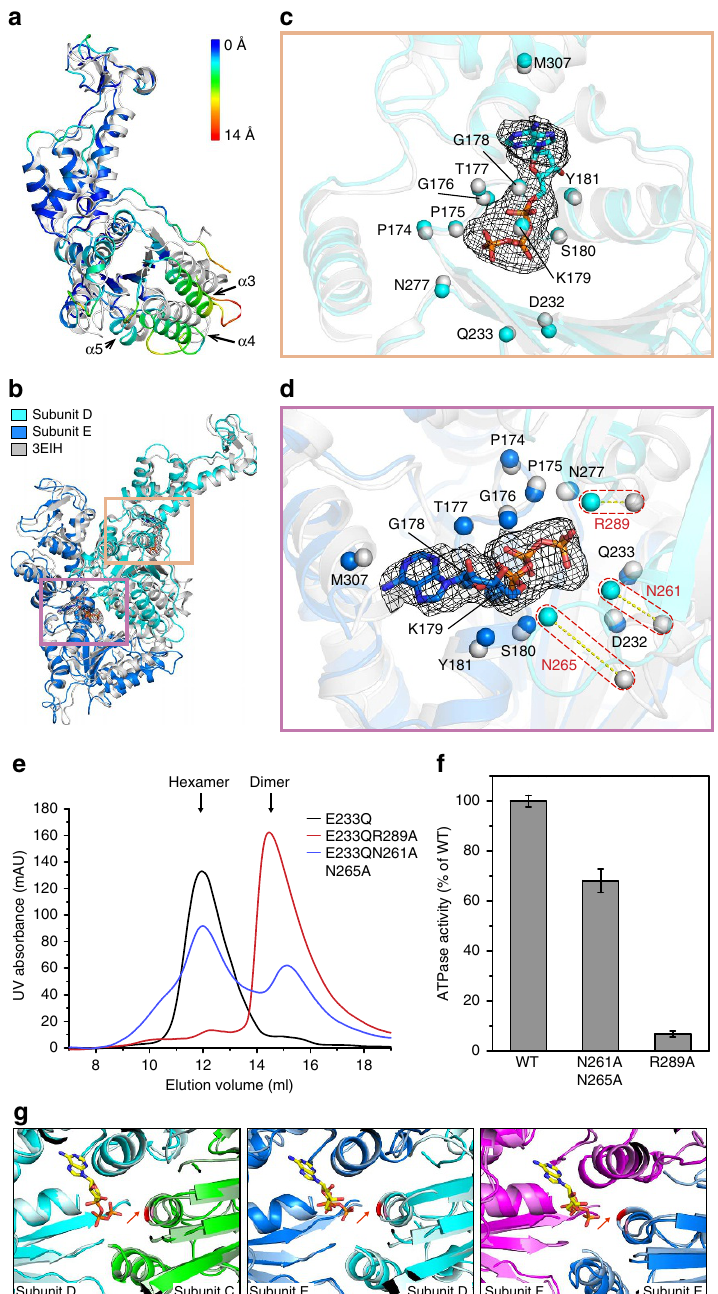
Figure 3 | ATPase active centres. ( a ) Comparison of subunit D with the crystal structure of the ATP g S-bound Vps4 E233Q (PDB ID: 3EIH) 12 . The crystal structure is coloured grey, and the subunit D is coloured based on the distances between aligned C a atom pairs with colouring scheme showing on the right. Helixes a 3, a 4 and a 5 are labelled and marked by black arrows. ( b ) A focused view of the adjacent Vps4 E233Q subunits D and E with each subunit superimposed with the crystal structure of the ATP g S-bound Vps4 E233Q . Two ATPase active centres are boxed and detailed in ( c , d ). ATP molecules are shown in stick representation, and the map density shown in mesh. ( c , d ) Close-up views of the ATPase active centre in subunit D ( c ) and subunit E ( d ). Residues contributing to ATP binding are shown in sphere representation. Large shifts of R289, N261 and N265 in subunit D compared with those in the crystal structure are shown by red dashed boxes in ( d ). The orientations of all close-up views are optimized to show the positions of the residues contributing to ATP binding. All alignments were done using the residues in Walker A loop (Phe174-Tyr181), Walker B (Asp232-Gln233), sensor 1 (Asn277) and M307 as a reference. ( e ) SEC analyses of the oligomeric states of the Vps4 mutants. ( f ) The ATPase activity assays. Data are represented as the average of three independent experiments. Error bars represent s.d. ( g ) Comparison of the ATPase centres of Vta1-free and Vta1-bound Vps4 E233Q hexamers. The colouring scheme is the same as in Fig. 1c,e. The ATP molecules in the Vta1-bound Vps4 E233Q hexamers are displayed in stick model. The R289 residues (red arrows) in Vta1-free and Vta1-bound Vps4 E233Q hexamers are coloured by pink and red, respectively. All alignments were performed using the subunits that the arginine fingers act on in trans